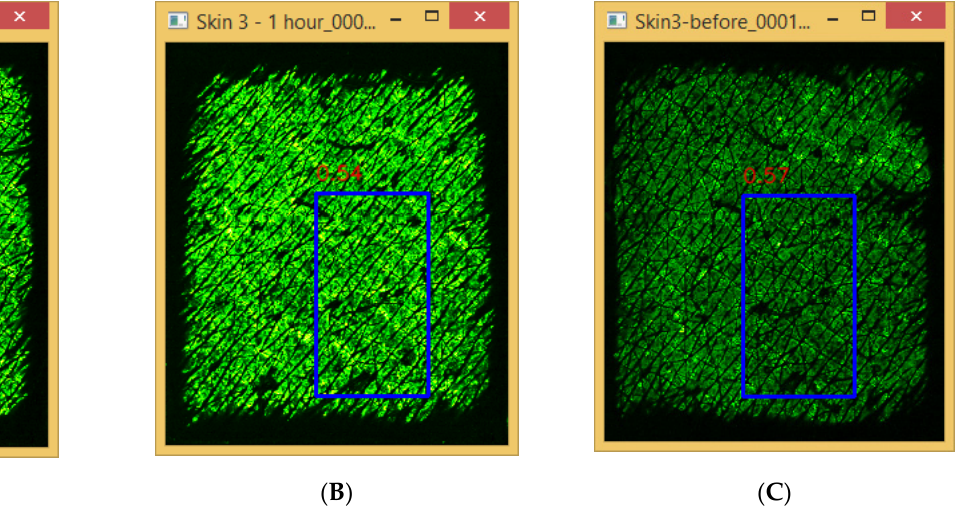
Figure 6. The region of interest (ROI) shown as crossed rectangle in the first image ( A ), and the best matching locations in the second image ( B ) and the third image ( C ), shown as empty rectangles.